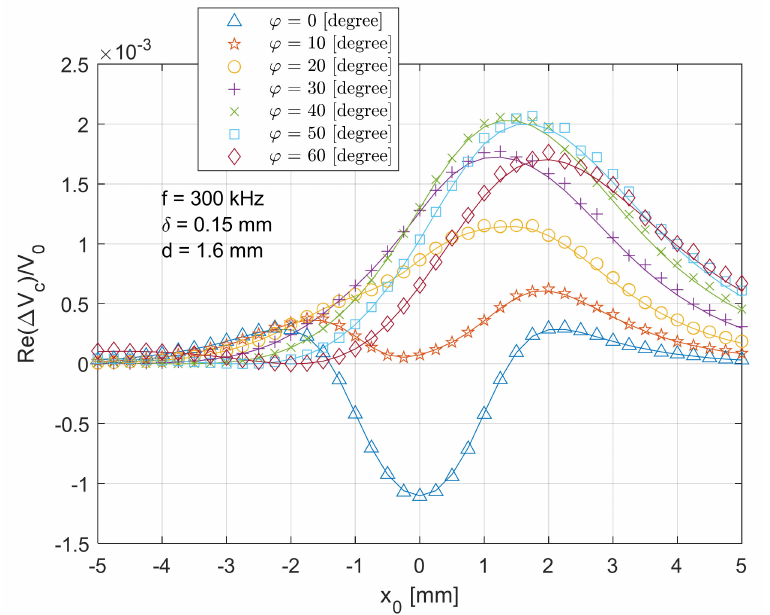
Figure 11. Comparison of analytical (lines) and experimental (markers) results for the real part of normalised voltage change (due to the crack) for the T-R sensor scanning across ( x direction in Figure 2) and through the crack centre with the depth of 1.6 mm and different tilt